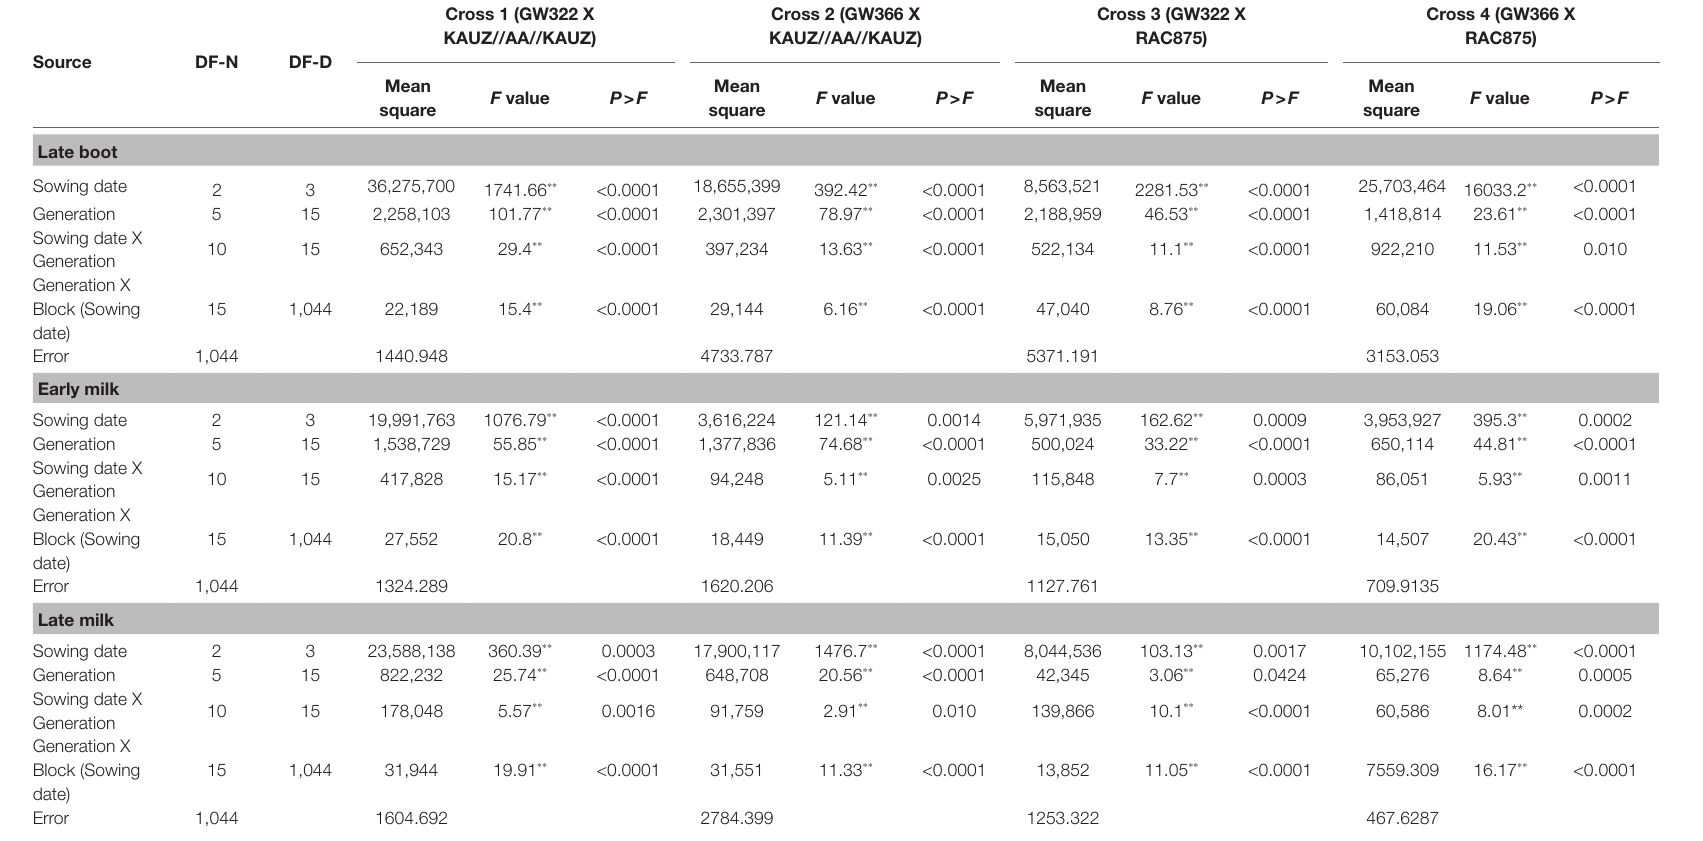
TABLE 1 | Mean sum of squares for stomatal conductance during three growth stages in four crosses.